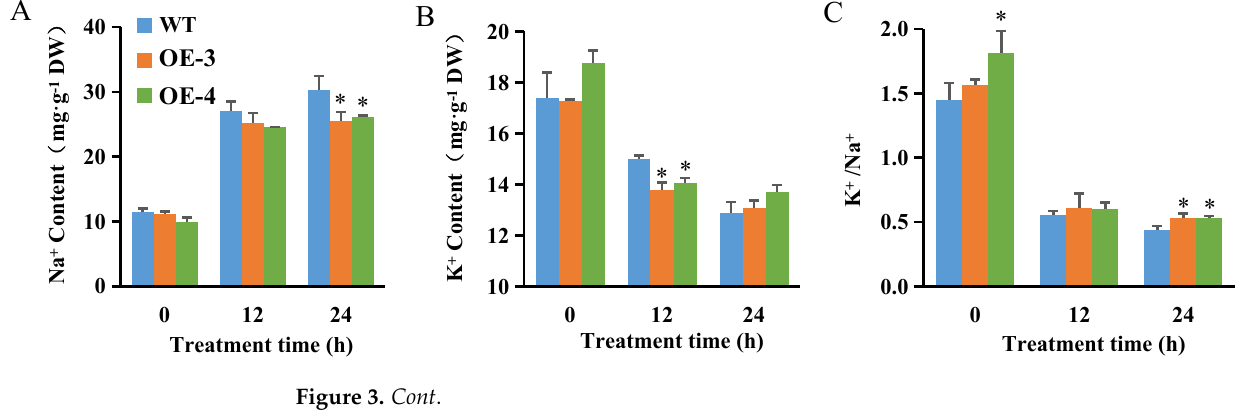
Figure 3. Overexpression of OsABT regulates Na + and K + levels under salt stress. ( A − C ) Na + content, K + content, and K + /Na + ratio in the roots of two − week − old OsABT − OE lines (OE − 3 and OE − 4) and wild type (WT) plants exposed to salt stress (200 mM NaCl) for 0, 12, and 24 h. ( D , E ) Expression of OsSOS1 and OsHAK5 in the roots of two − week − old OsABT − OE line (OE − 3) and WT plants. Root RNA was isolated and used for quantitative real − time polymerase chain reaction (qRT − PCR). Actin was used as an internal control. The relative expression levels were represented by fold change rel- ative to the expression of WT before salt treatment (0 h). Data are means ± SD of three independent experiments. Asterisks indicate significant differences compared to WT plants at * p < 0.05 and ** p < 0.01 (Student’s t − test). 2.4. Overexpression of OsABT Inhibits ABA Synthesis under Salt Stress Abscisic acid (ABA) greatly contributes to plant growth and development and plays a key role in controlling the adaptive response of plants to environmental stresses. ABA accumulation and biosynthesis genes are upregulated under salt stress [53]. We found that the ABA content in the roots of the OsABT-OE line (OE-3) was lower than that of the WT plants. Meanwhile, the leaf ABA content showed first an increasing and then a de- creasing trend in all plant lines under salt stress, but this tendency was weakened in OE- 3 (Figure 4A,B). The root expression of the ABA synthesis genes OsNCED3 and OsNCED4 , and the ABA catabolic gene OsABA8ox2 were further examined. The results showed that the ex- pression of these genes was dramatically induced in all plant lines under salt stress. Com- pared to the WT plants, the expression of OsNCED3 and OsNCED4 in OE-3 was lower, while that of OsABA8ox2 in OE-3 was higher. At 24 h of salt treatment, the expression levels of OsNCED3 and OsNCED4 in OE-3 was only 43.55% and 46.24% of WT, while the expression of OsABA8ox2 was 1.59-fold of WT (Figure 4C – E). ABA is synthesized in roots and transported to the leaves for accumulation under salt stress [33]. These results indicate that OsABT can inhibit ABA synthesis in rice roots by inhibiting the expression of ABA synthesis genes and promoting the expression of ABA catabolic genes, thereby reducing the leaf ABA content.